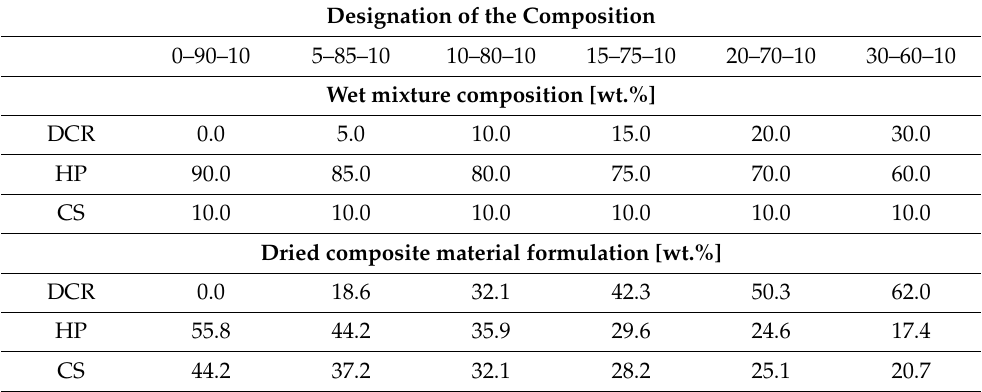
Table 2. The composition of block and granules in a raw mixture (wet) and after drying, by wt.% (part